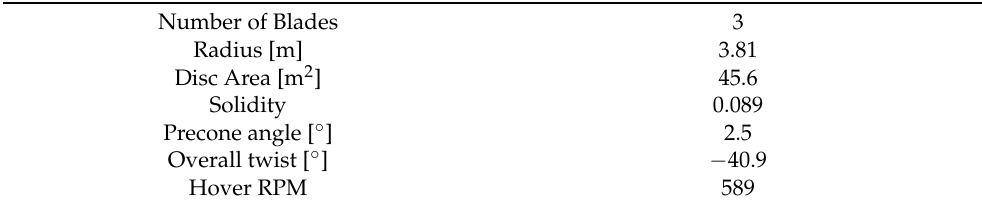
Table 1. XV-15 full-scale proprotor characteristics.